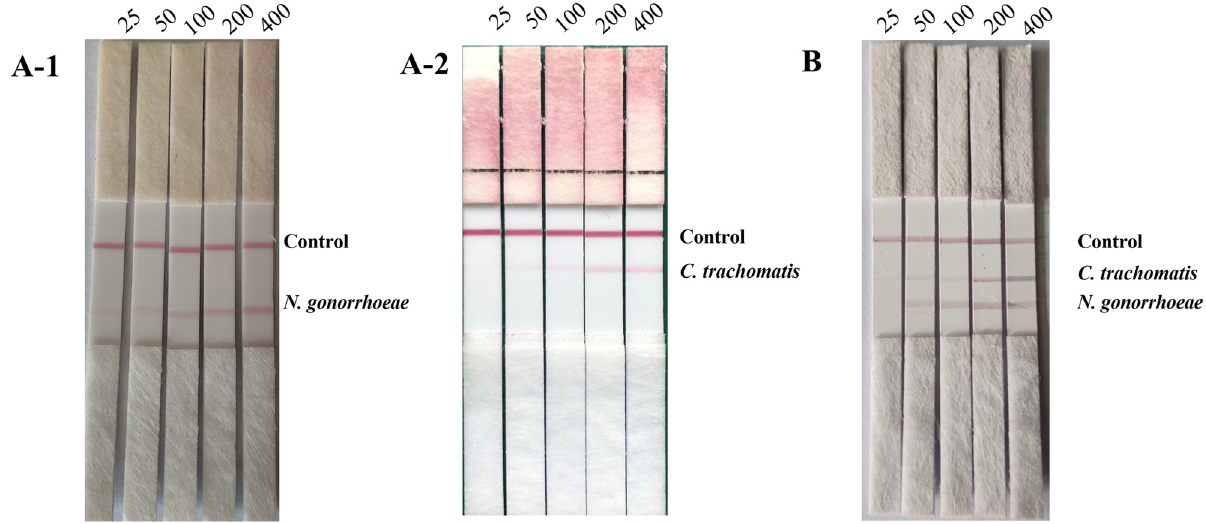
Fig 4. Sensitivity test of multiple LFD-RPA detection. A: Assay results when NG or CT positive control plasmids of different copy numbers were used as templates, respectively; B: Assay results when NG or CT positive control plasmids of different copy numbers were used in the same system. The RPA was performed at 38˚C for 10 min with magnesium ion concentration at 16.8 nM, CT-RPA primer concentration at 400 nM and NG-RPA primer concentration at 200 nM.